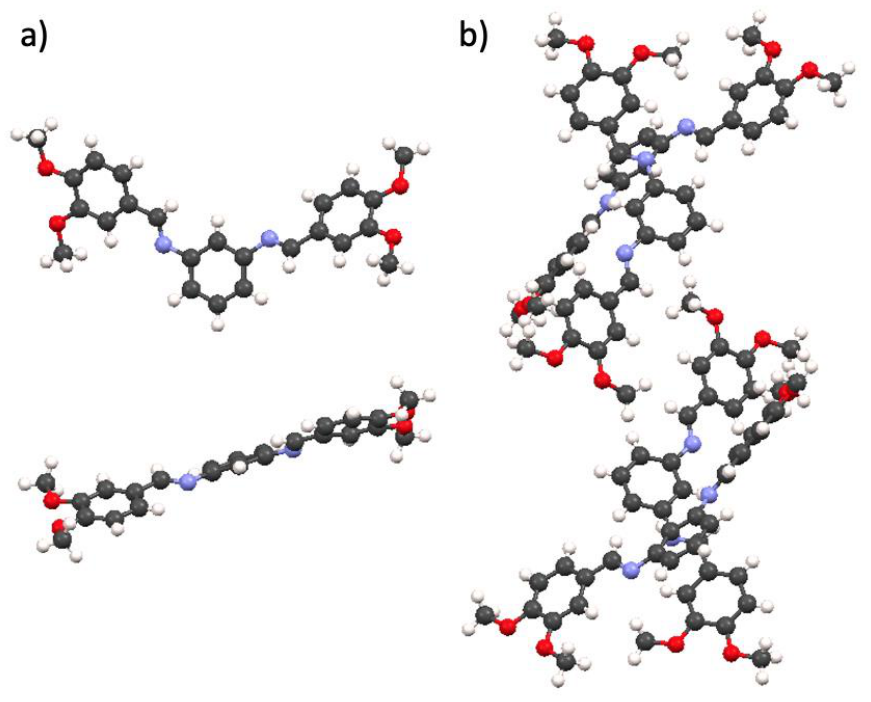
Figure 6. XRD structure of M2 ; ( a ) Face and side view. ( b ) Packing represented with 4 molecules in the lattice (right).